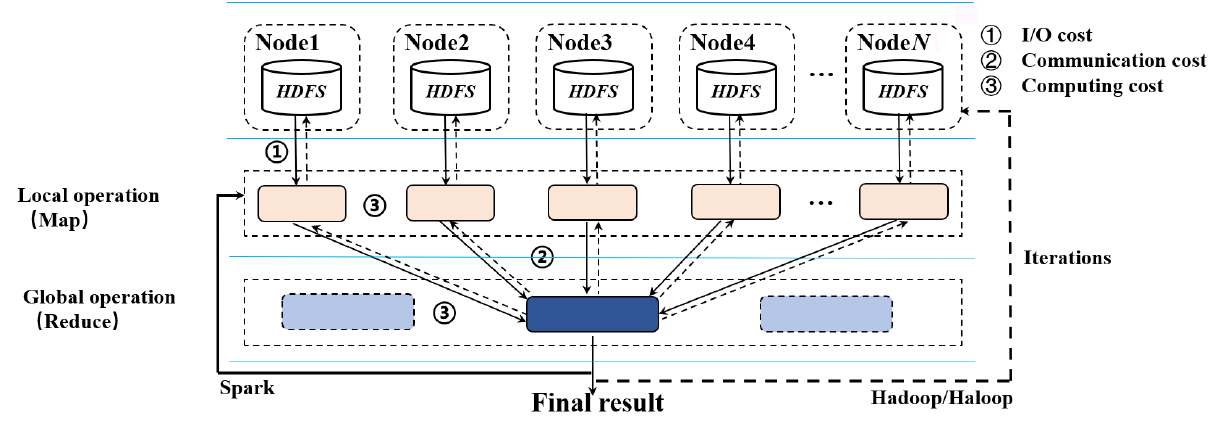
Fig. 2 MapReduce-type distributed computing framework. Hadoop and Haloop iterative algorithms generate I/O, communication, and computing costs repeatedly, whereas Spark reduces I/O costs significantly by using in-memory